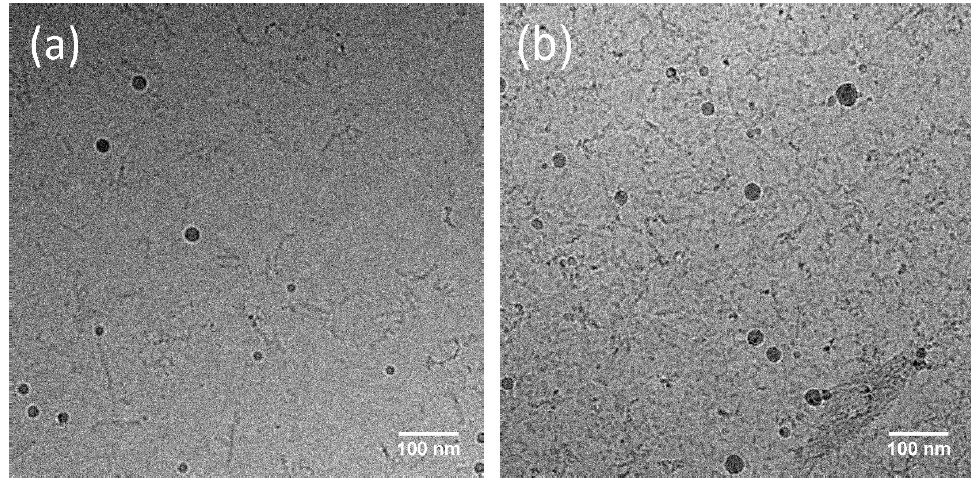
Figure 6. Representative cryo-TEM images of diluted mixed aqueous solution (1.0 mM) before irradiation ( a ) and after UV light irradiation (365 nm, 30 min) ( b ).